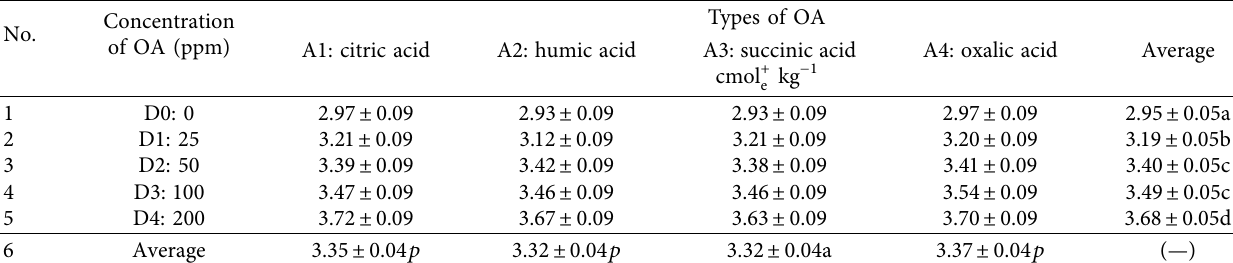
Table 4: Efect of OAs application on PR to Ca 2+ average from 4 observation times.